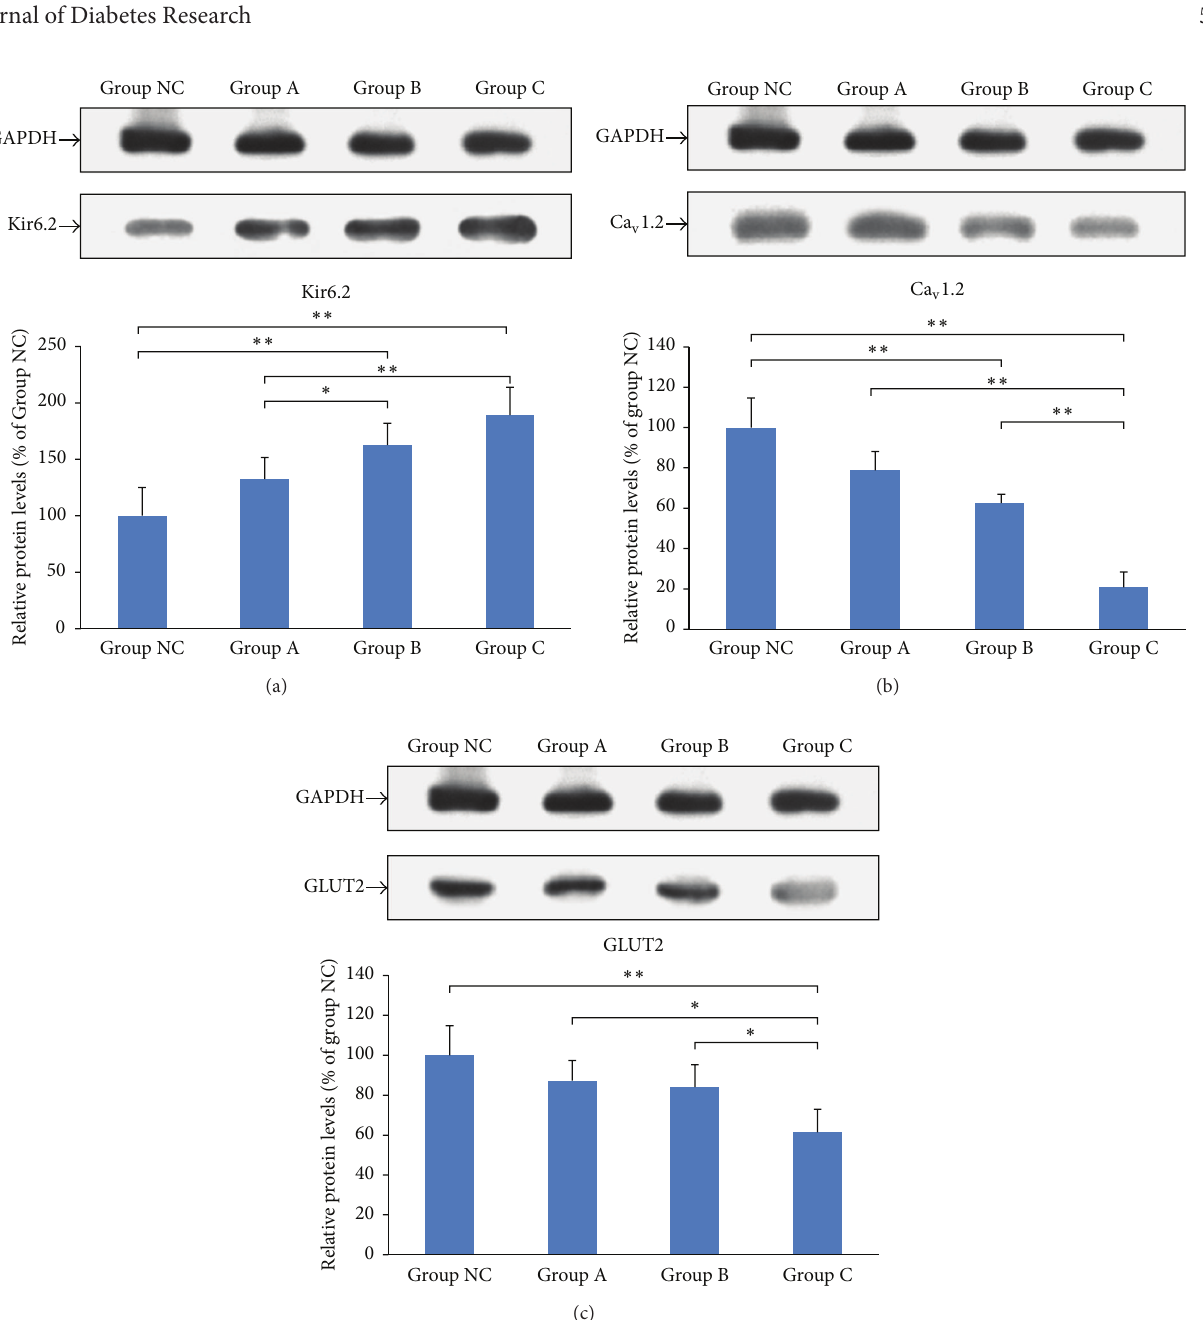
𝑃 < 0.05 was considered statistically significant. Bars in the graph represent